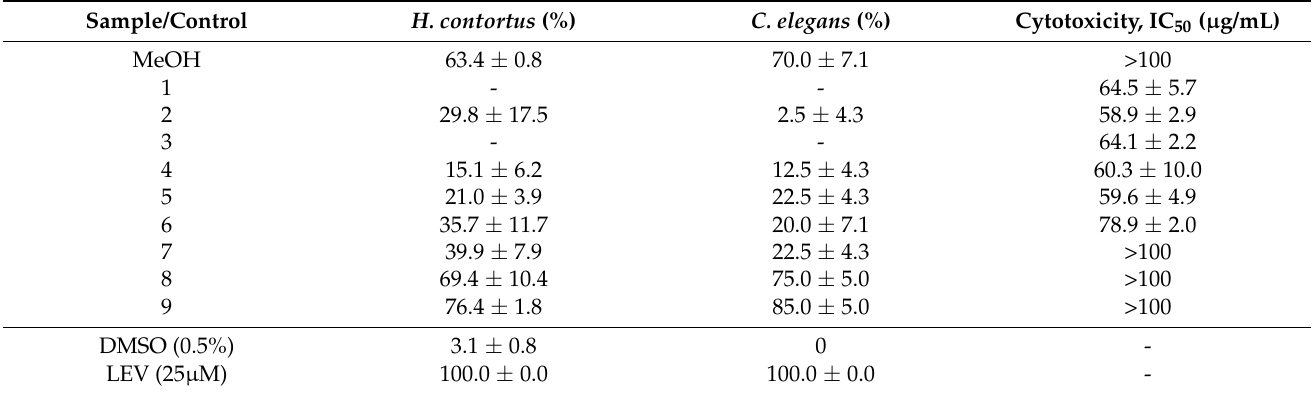
Table 1. Migration inhibition rate (%) of Haemonchus contortus L3 larvae, mortality rate (%) of Caenorhabditis elegans young adult worms treated with Terminalia leiocarpa MeOH extract and its fractions at a concentration of 600 µ g/mL and cytotoxicity (IC 50 ) on fibroblast cells